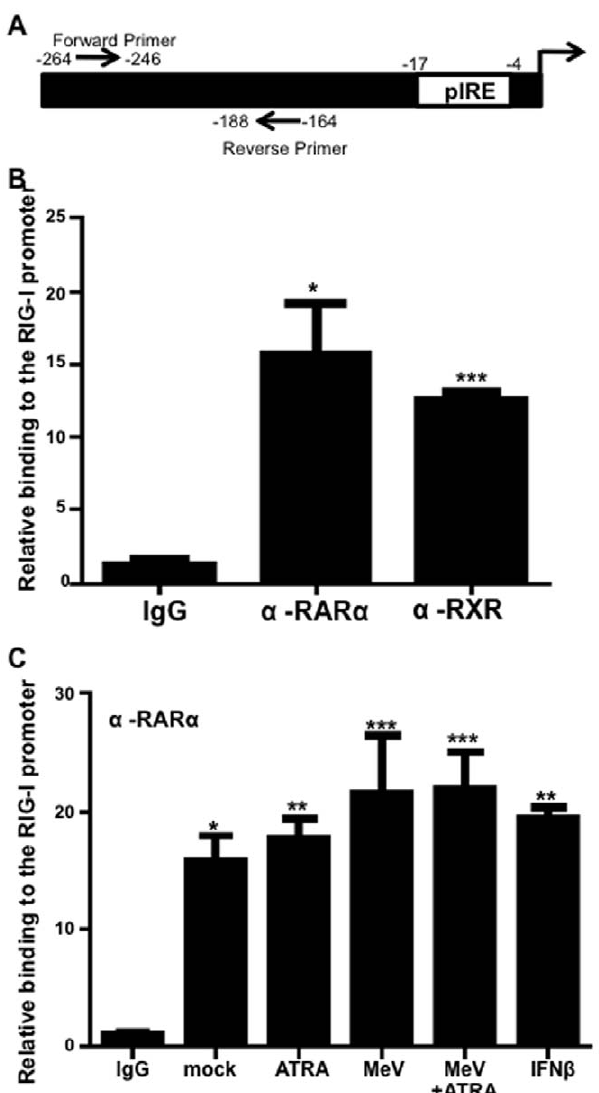
Figure 5. Retinoic acid nuclear receptors bind to the RIG-I promoter. (A) Diagram of the RIG-I promoter showing the known IRF1 binding site. Arrows represent the site of primers used in ChIP experiments. (B) RAR a and RXR were immunoprecipitated from cells treated with 1 m M ATRA or DMSO (N=2) (C) U937 cells were infected with MeV at an MOI of 0.1 and/or treated with 1 m M ATRA or DMSO for 24 hours. 1000 U/ml of IFN b was used as a positive control. These samples were then immunoprecipitated RAR a primary antibodies. The pulled-down DNA was analyzed by qPCR using primers specific for the RIG-I promoter as described in the materials and methods. Data presented are representative of three experiments performed in triplicate (N=3). *p , 0.05, **p , 0.01, ***p , 0.001.